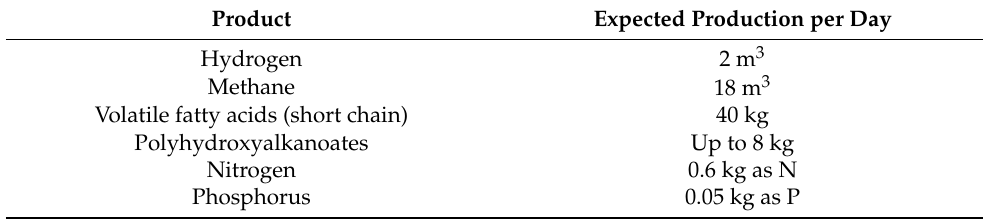
Table 2. Expected quantitative products obtained from the overall AgriLoop